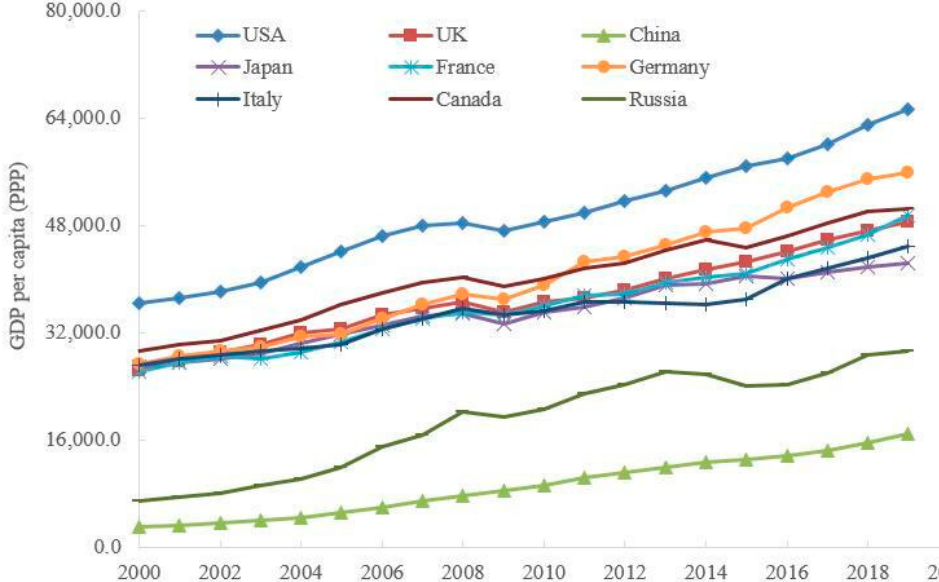
Figure 3. The trends of GDP per capita of selected countries. Source: https://data.worldbank.org/indicator/NY.GDP.PCAP.CD, accessed on 22 October 2022.